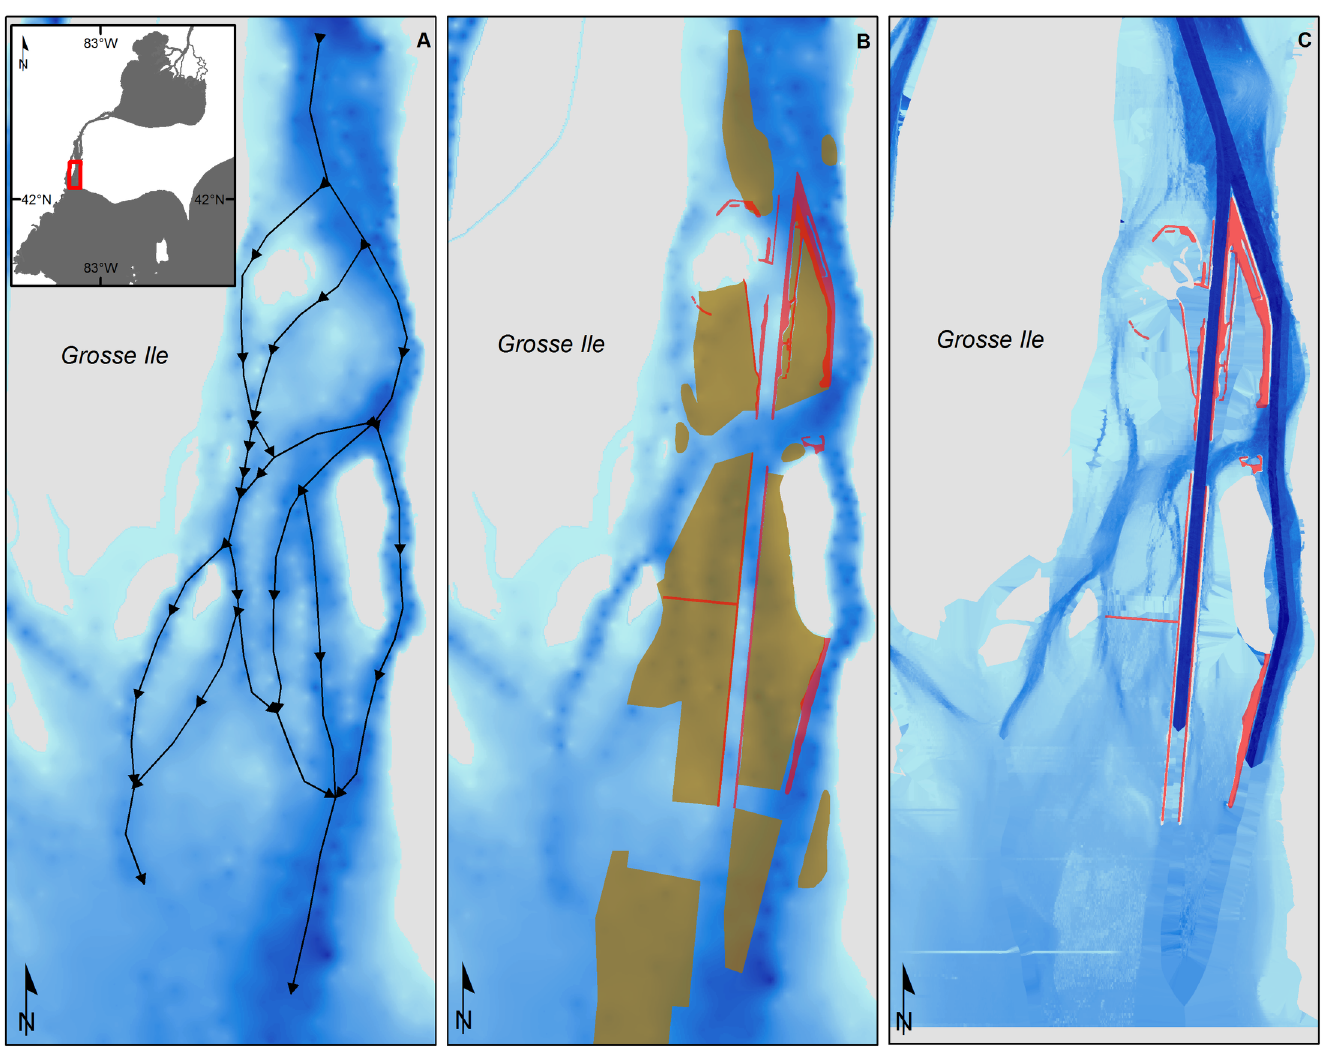
Fig 3. Bathymetry of the lower Detroit River east of Grosse Ile before (A, B) and after (C) channelization (circa 1900vs. 2012). Black arrows indicate potential pathways for fish movement. Brown-shadedareas show dredgespoil disposallocations.Above-water compensatingworks are shown in red. Bathymetry data for the lower Detroit River in 2012 was providedby the U.S. Army Corps of Engineers-Detroit